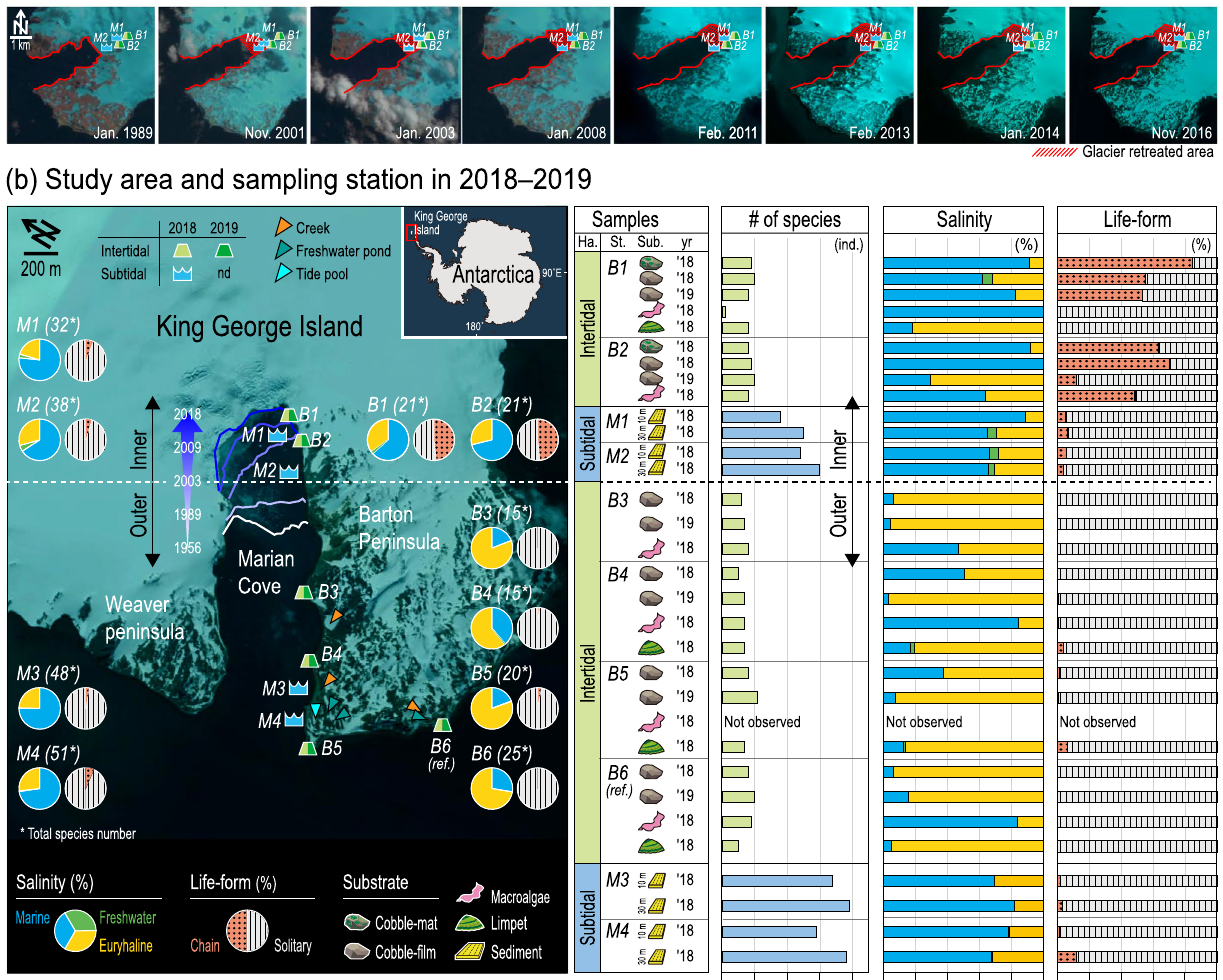
Figure 1. Overview of the study area, sampling locations, and benthic diatom community data; ( a ) Overlook showing glacier retreat in Marian Cove, West Antarctica, since 1989. Stations in the inner part of the cove are presented (B1, B2, M1, and M2). ( b ) Map showing sampling locations (intertidal zone: B1–B6; subtidal zone: M1–M4 at 10 and 30 m) surveyed in 2018–2019, with a summary of benthic community data; specifically, the number of species, relative abundance by salinity (marine, euryhaline, and freshwater), life-form (chain and solitary), and various substrates (cobble-mat, cobble-film, macroalgae, limpet shell, and sediment).